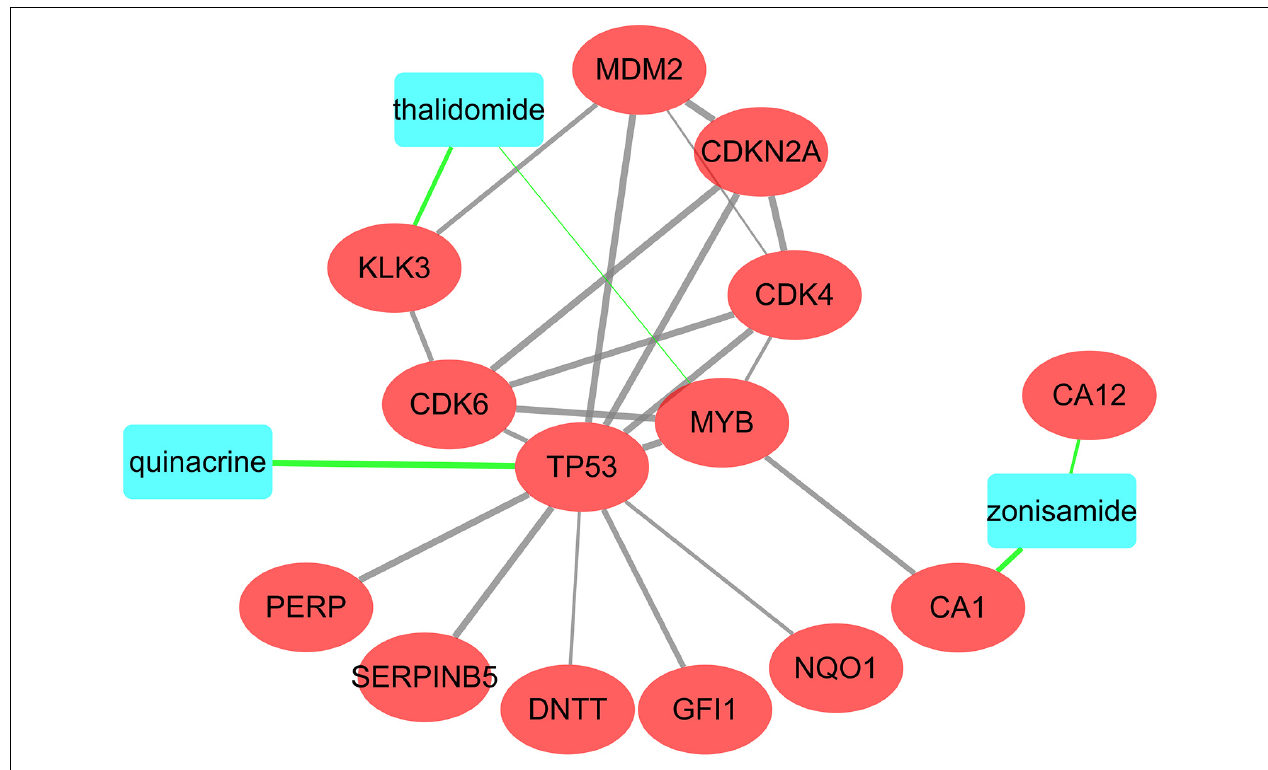
FIGURE 8 | Interactions among the three potential drugs and proteins coded by mRNAs. The blue rectangle represents the drugs and the red oval represents the proteins coded by shared mRNAs and other predicted proteins involved in the